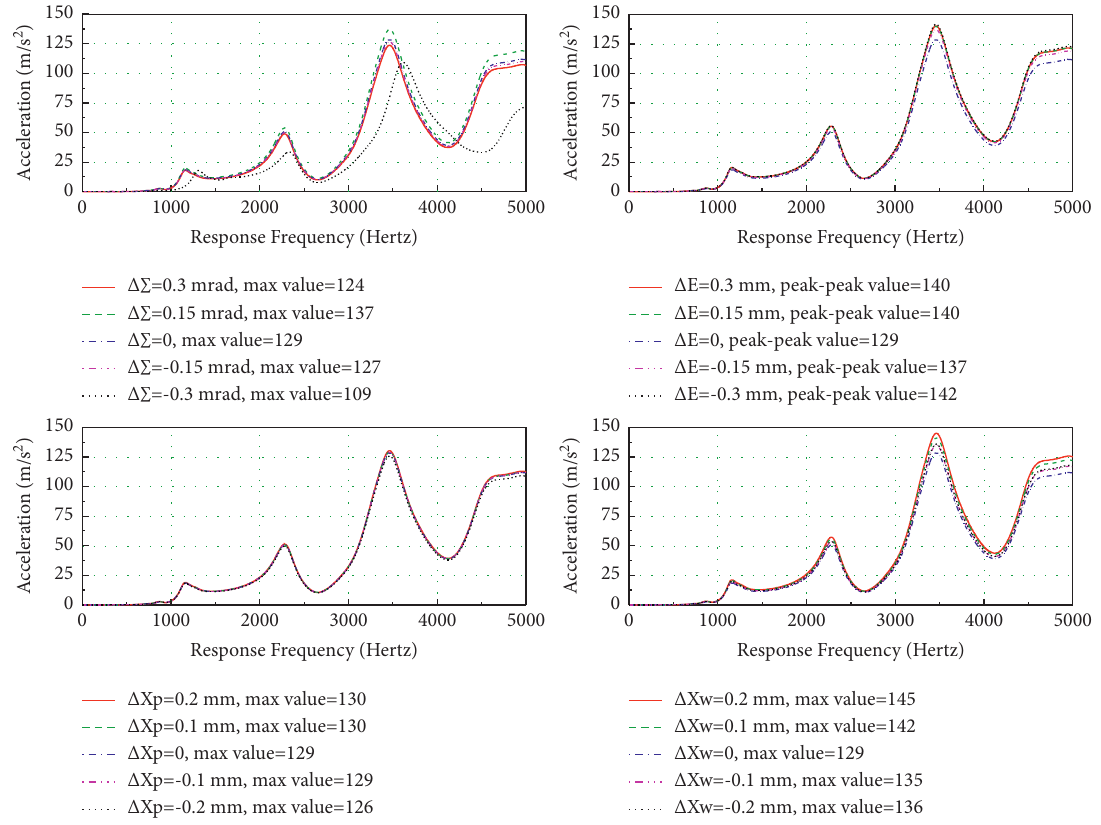
Figure 15: Vibration acceleration in frequency